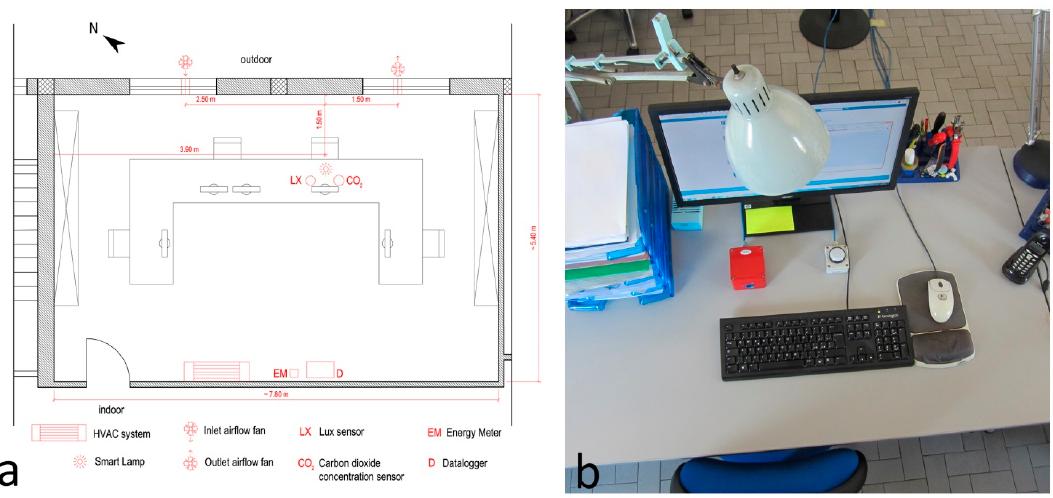
Figure 6. Installation in working conditions: ( a ) plan of the office; ( b ) workstation with smart lamp and sensors.